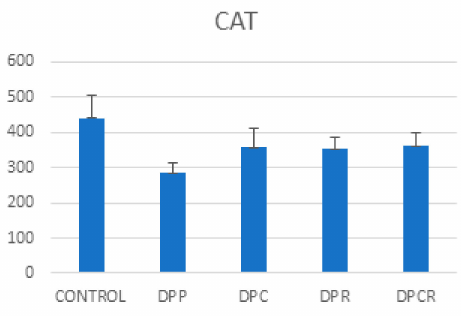
Figure 3. Mean variable evolution of catalase